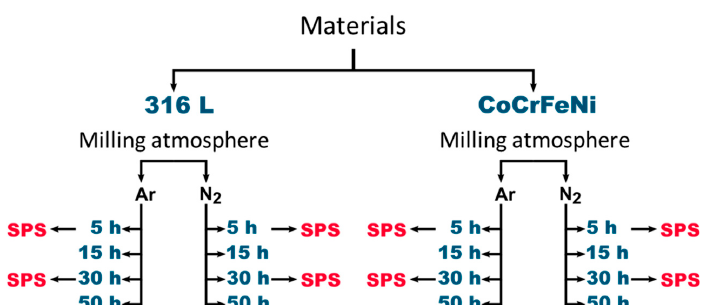
Figure 1. Schematic representation of various powder materials prepared using a set of variable milling parameters (time, atmosphere). The 316 L alloy atomized powder and CoCrFeNi powder prepared from pure elements was used for milling experiments. Powder samples designated by the spark plasma sintering (SPS) arrow were subsequently densified.